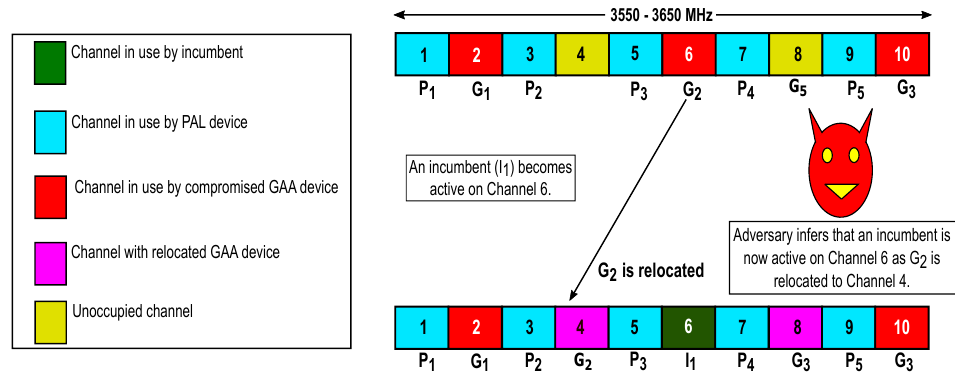
Figure 9. An example of operation frequency privacy violation of the incumbent in